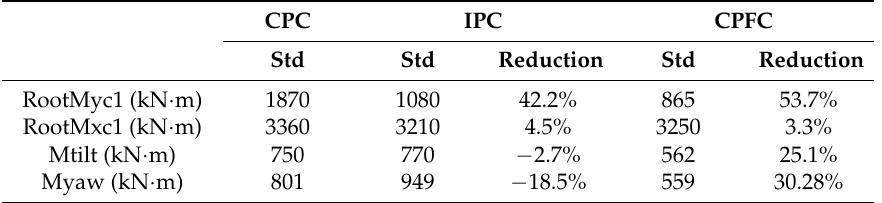
Figure 12. The DEL of wind turbine. Table 5. The details of DEL.